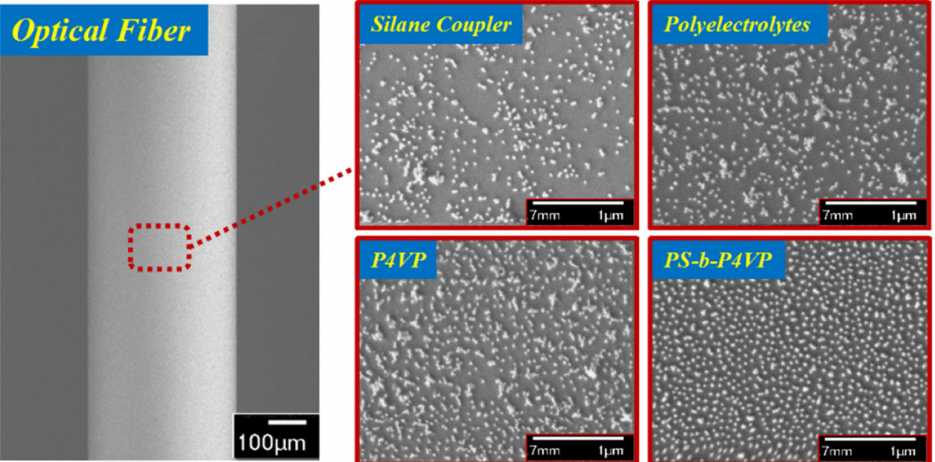
Figure 3. The scanning electron microscopy (SEM) images of AuNP-coated fiber surfaces which were deposited by APTMS, polyelectrolytes, P4VP and the PS-b-P4VP monolayer,